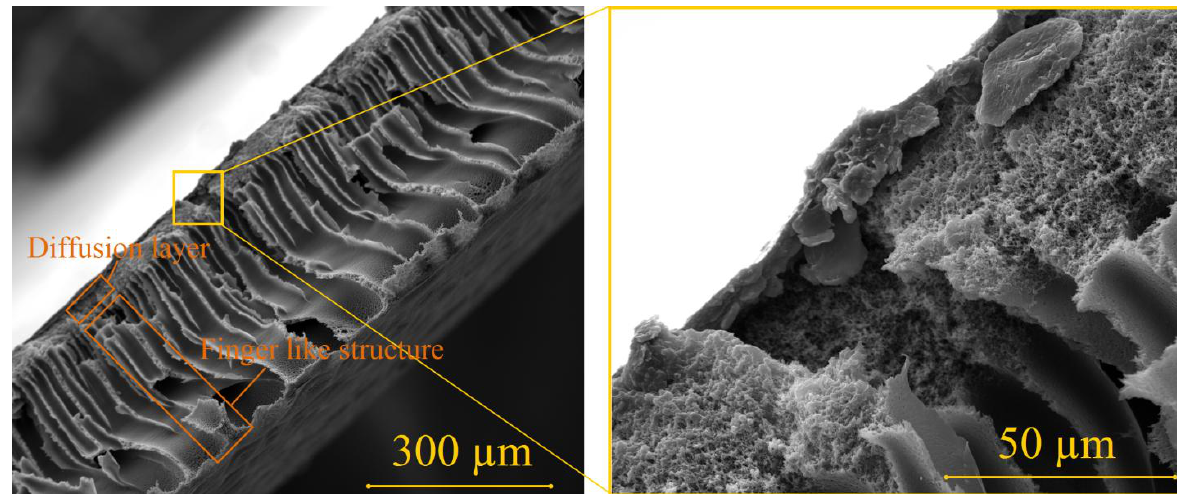
Figure 3. Cross section of PES